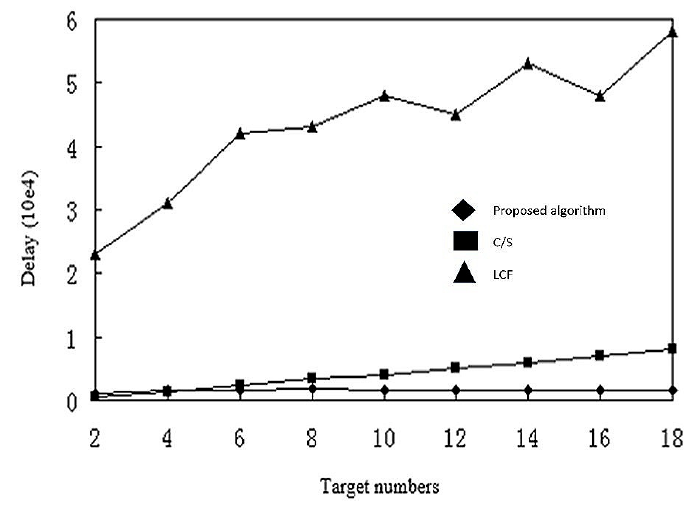
Figure 19. Delay for different target numbers.